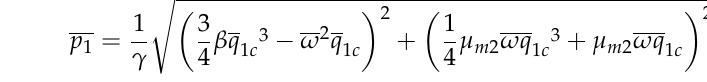
Figure 16. The time series for the system with the level of forcing F 1 = 2.01 and the frequency of